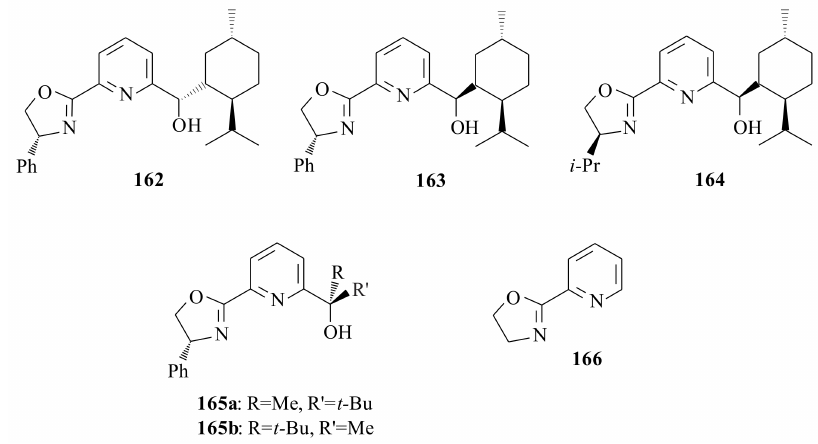
Figure 36. Chiral pyridinooxazoline ligands.